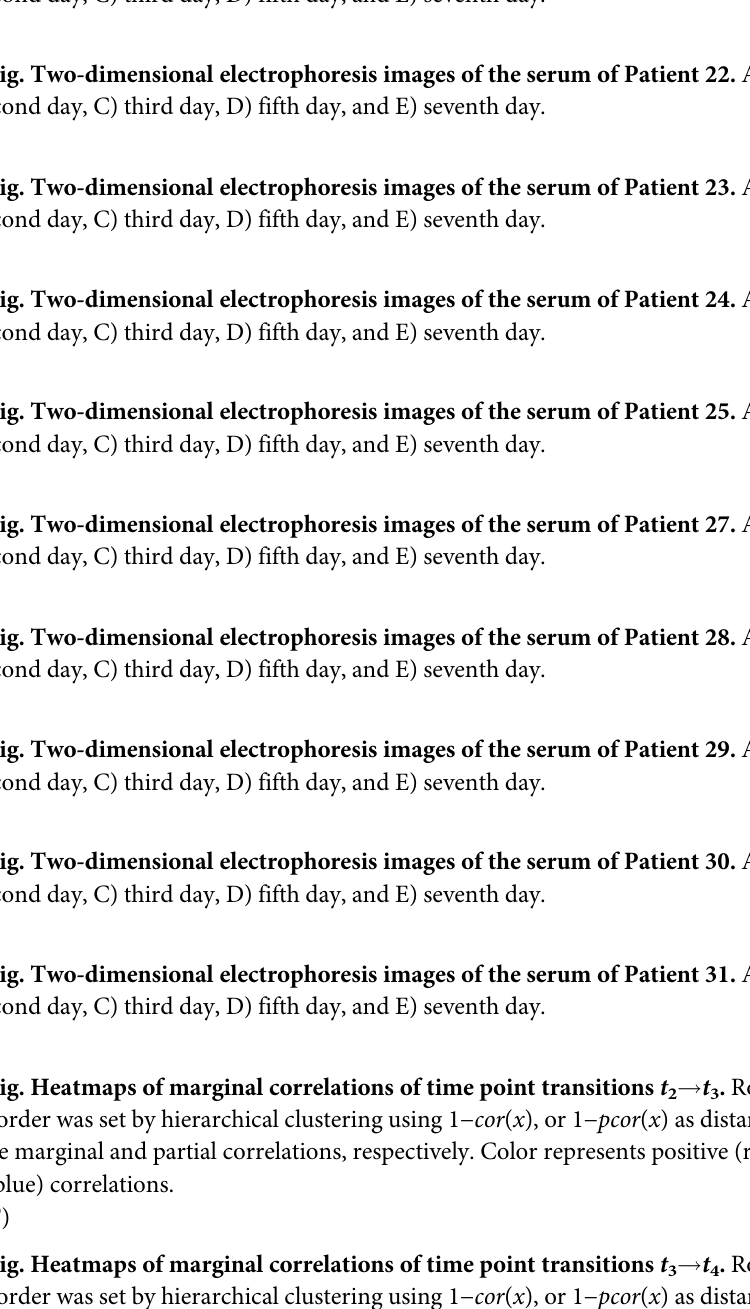
S10 Fig. Two-dimensional electrophoresis images of the serum of Patient 21. A) First day,